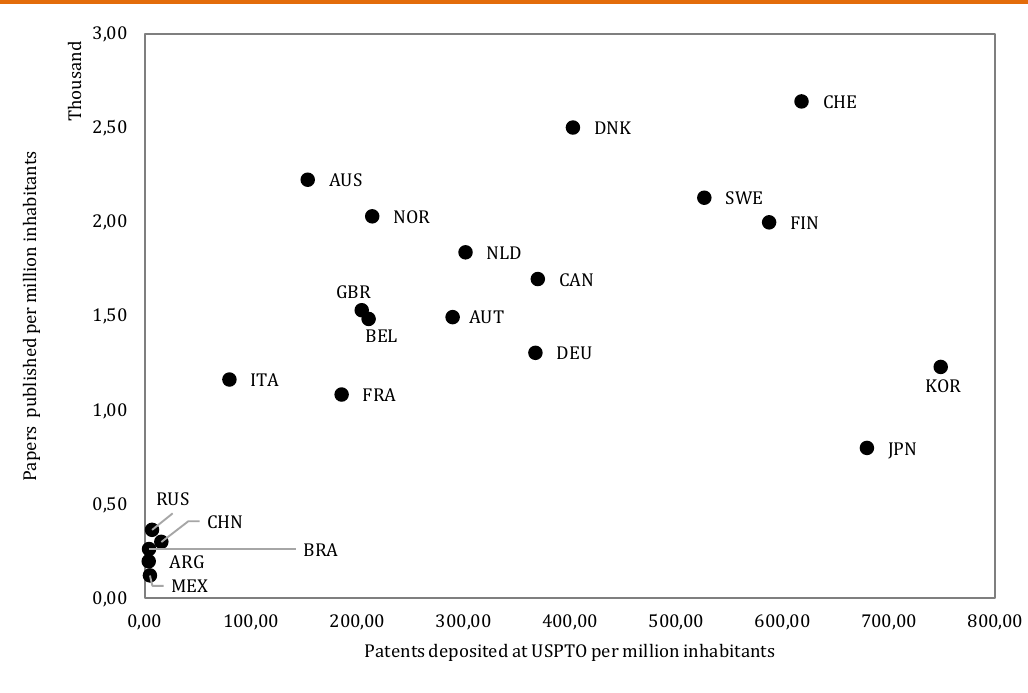
Figure 02 . Scientific and technical journal articles published, and patents filed per million inhabitants, 2015, selected